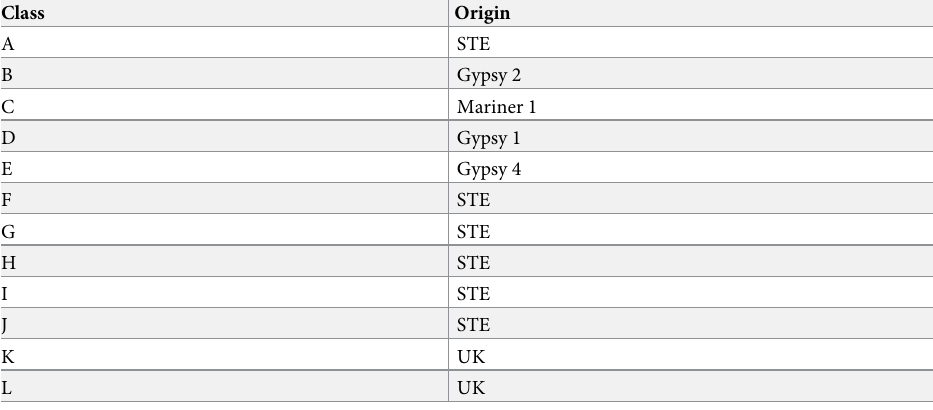
Table 3. Summary of composition of ATE classes in non-centromeric DNA.